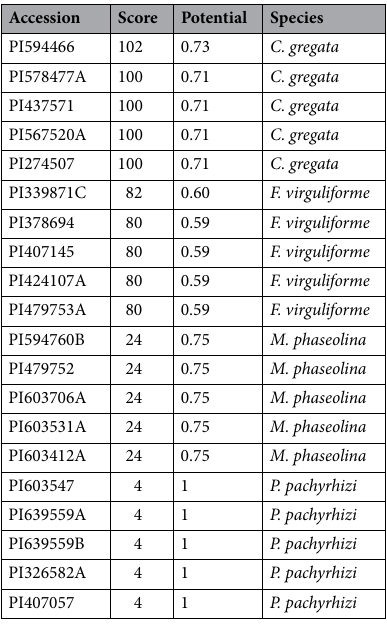
Table 3. Top 5 most resistant soybean accessions against each fungal pathogen. Overall, the best genotypes do not reach the maximum potential. An exception is observed for P. pachyrhizi -resistant genotypes, but this is likely due to the small number of resistance SNPs. None of the resistance SNPs for F. graminearum have been identified in the USDA SoySNP50k compendium and, hence, we could not predict resistance potential against this